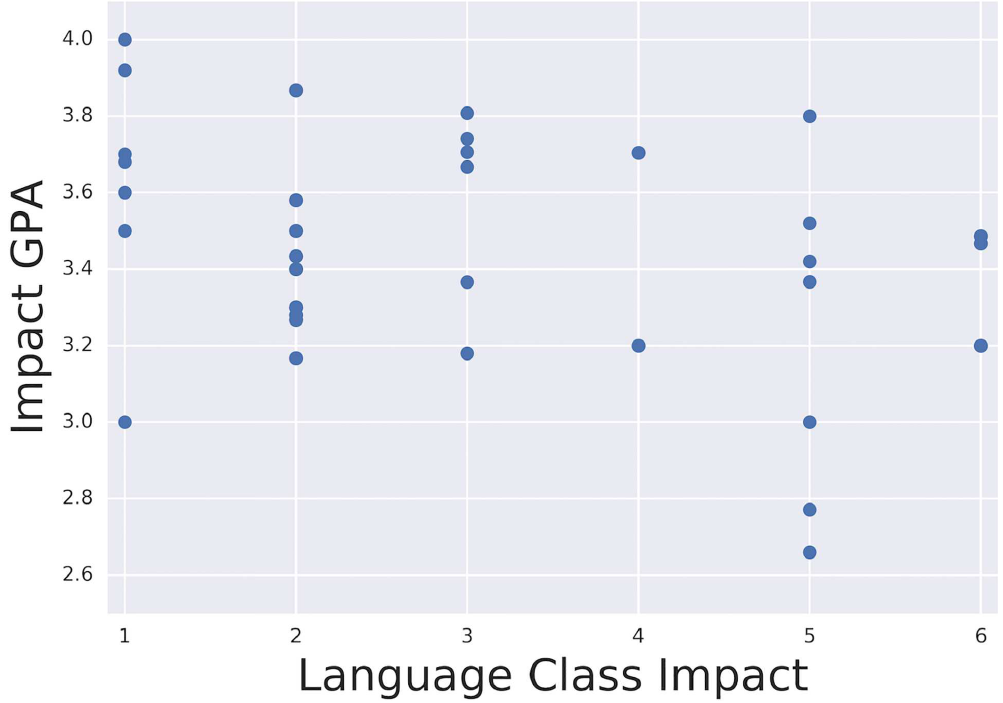
Fig 1. Impact GPA by Unit of Assessment vs. impact